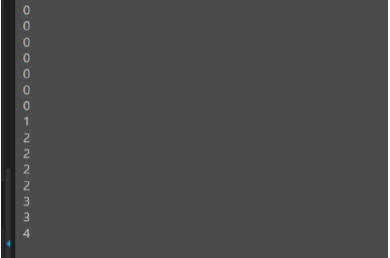
Fig. 8. Experimental simulation